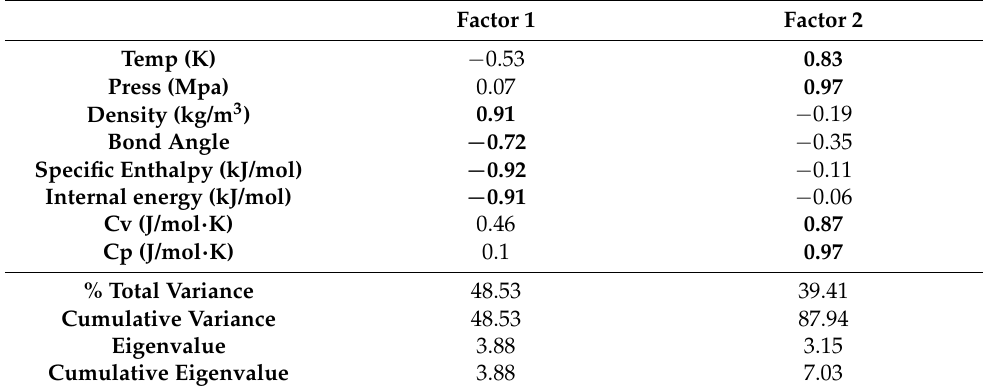
Table 3. Factor analysis and varimax rotation. Highlighted values are